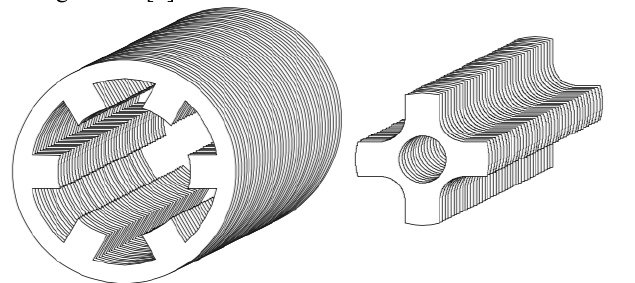
Fig. 1. Stator and rotor of a 6x4 SRM.